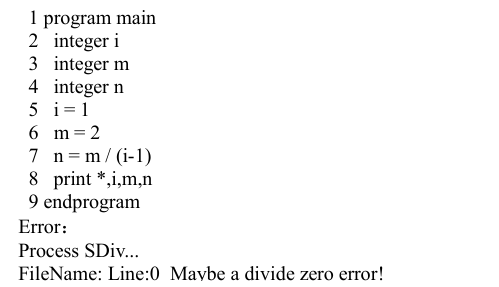
Figure 7 Fortran division zero example